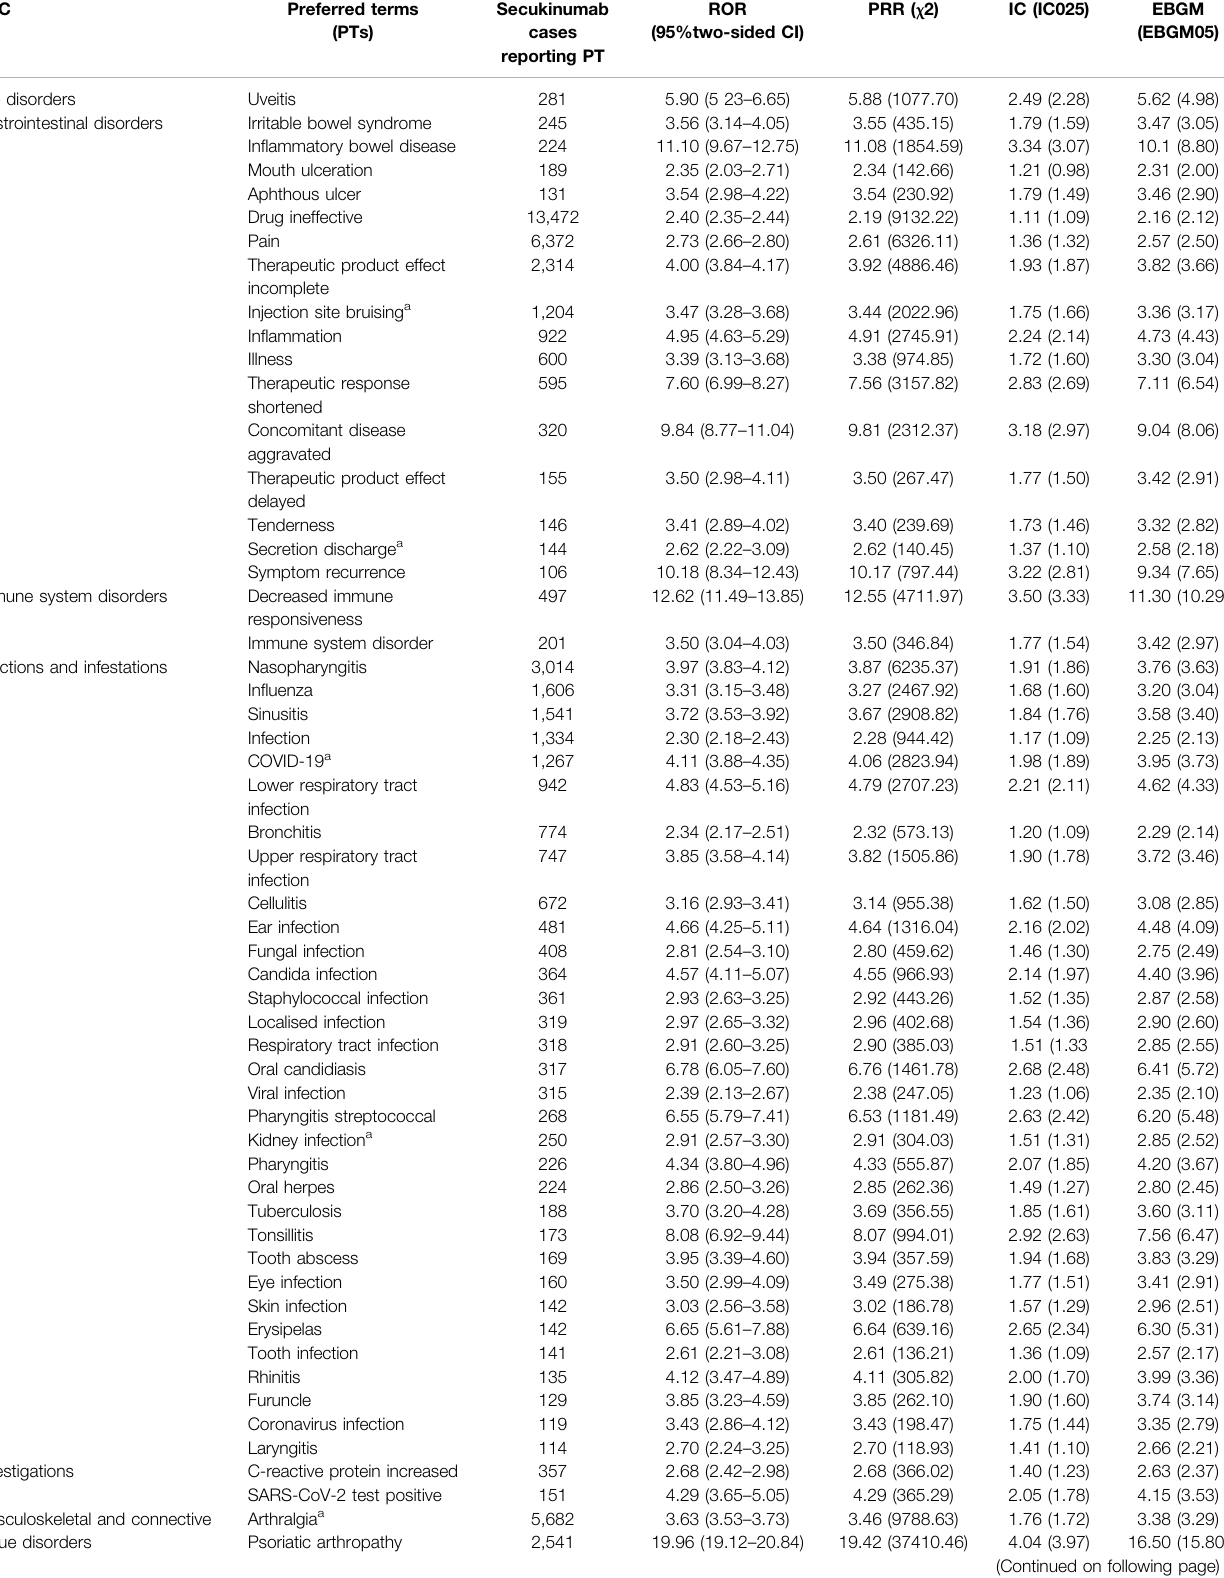
TABLE 3 | Signal strength of reports of secukinumab at the Preferred Term (PT) level in the FAERS